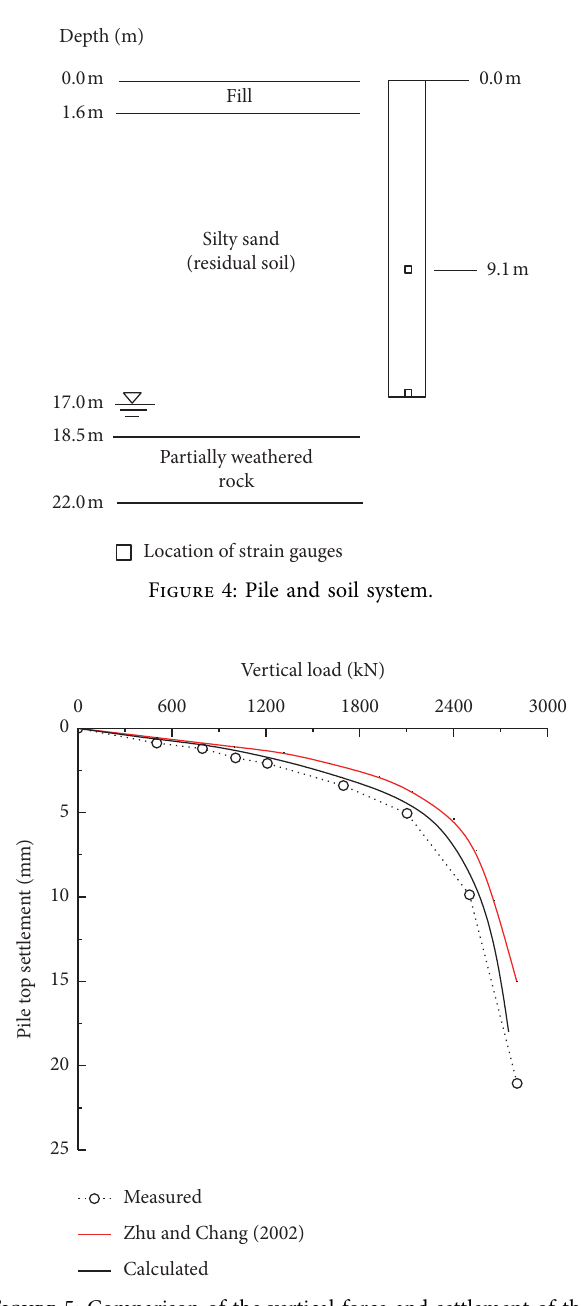
Figure 5: Comparison of the vertical force and settlement of the single pile.